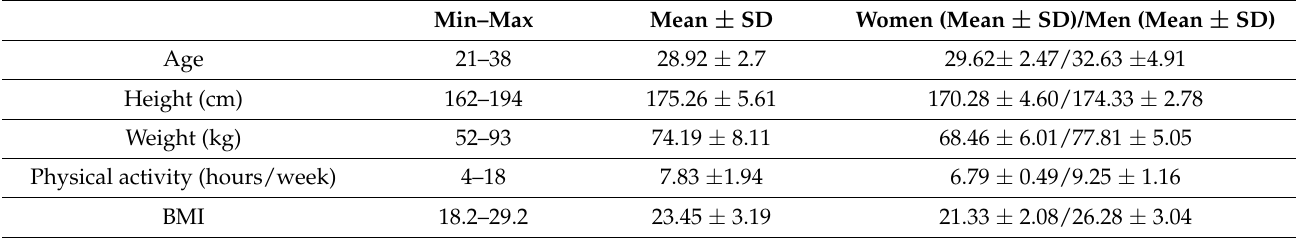
Table 1. Socio-demographic data of the